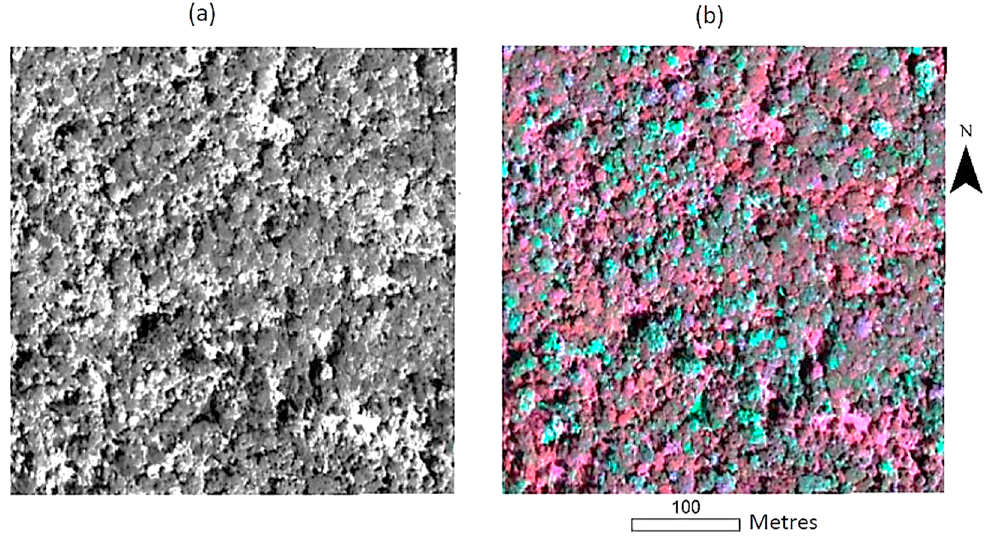
Figure 3. A subset of the WorldView-3 images of the study area: ( a ) band 8; ( b ) colour composite of bands 8, 5, and 3 (RGB).